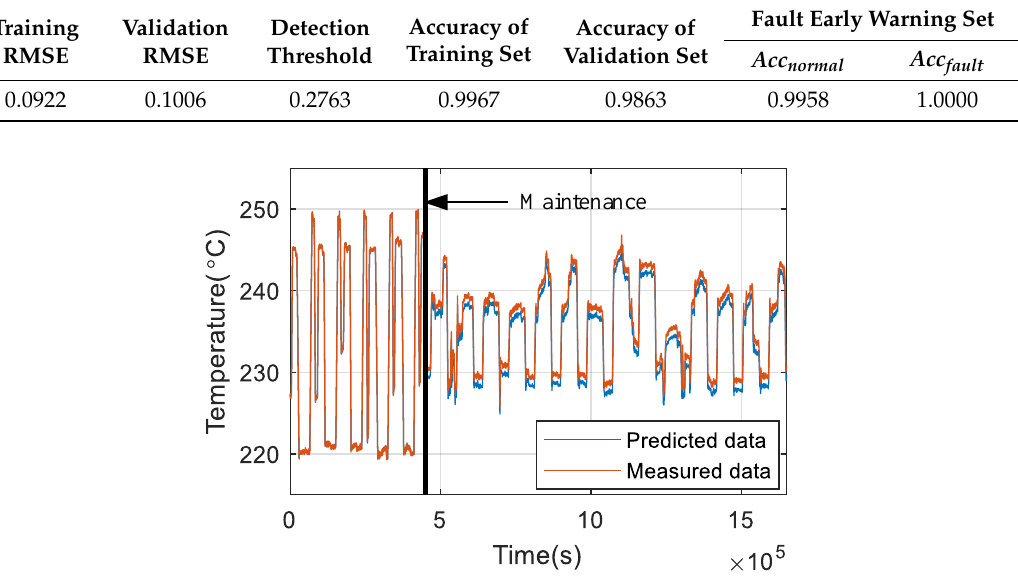
Figure 18. Performance in fault early warning set.